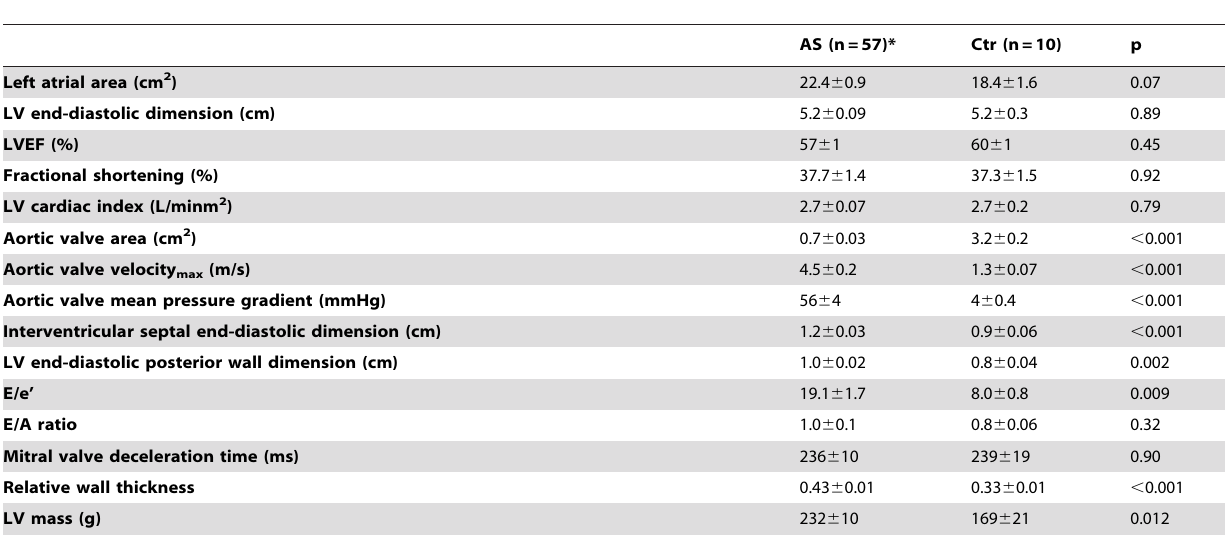
Table 2. Echocardiographical data in the patients with aortic stenosis and control